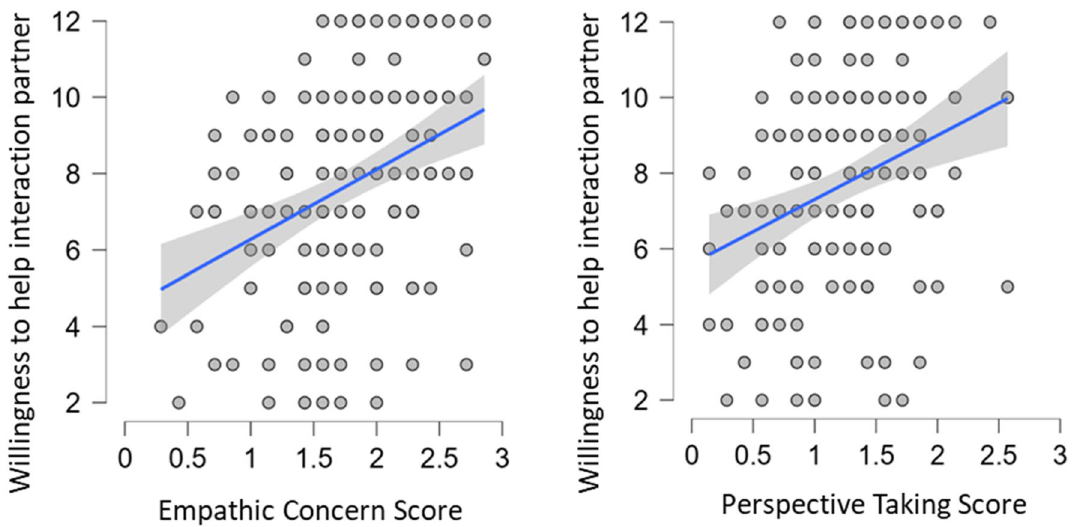
Figure 3. Willingness to help (anti-)mimicking interaction partner (confederate) in relation to perspective taking (left) and empathic concern scores (right). Shaded area: credible interval